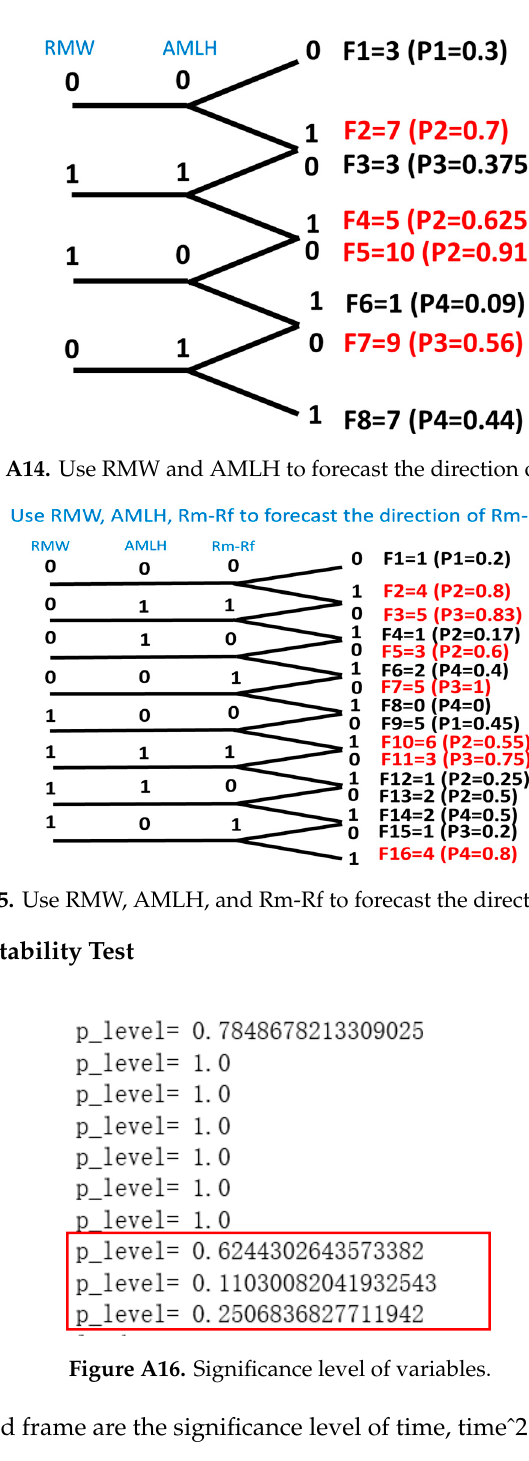
Figure A16. Significance level of variables.